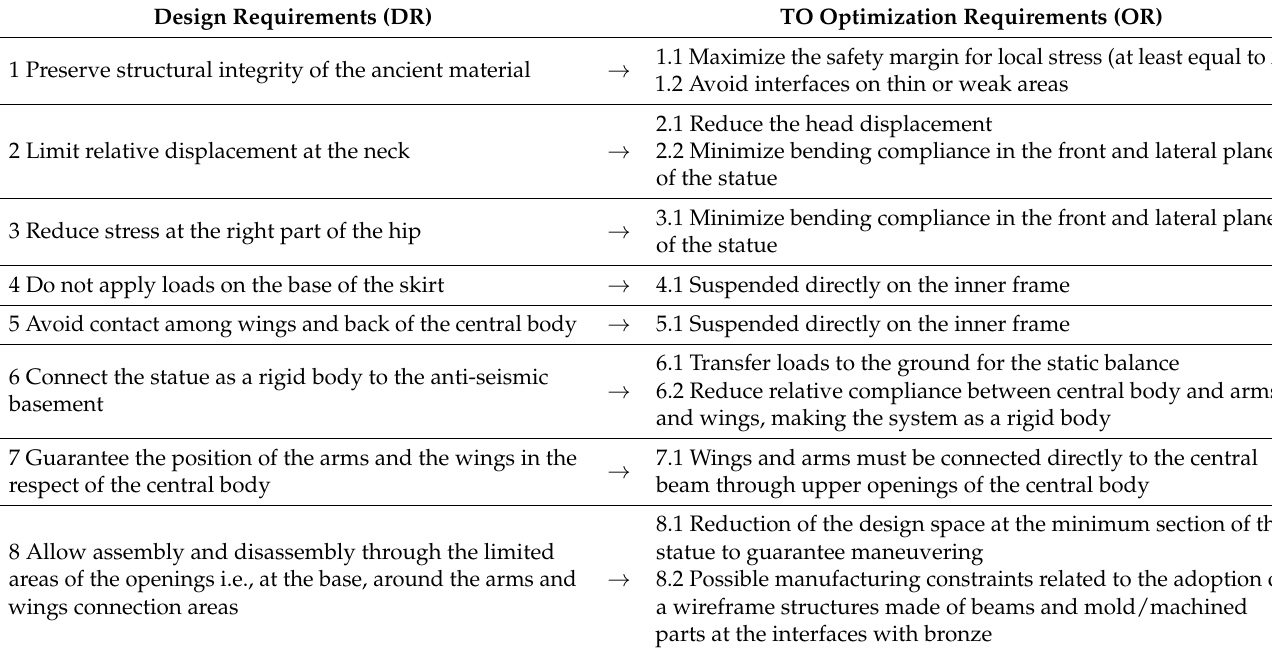
Table 1. Design Requirements declared by the restorers and their translation to optimization